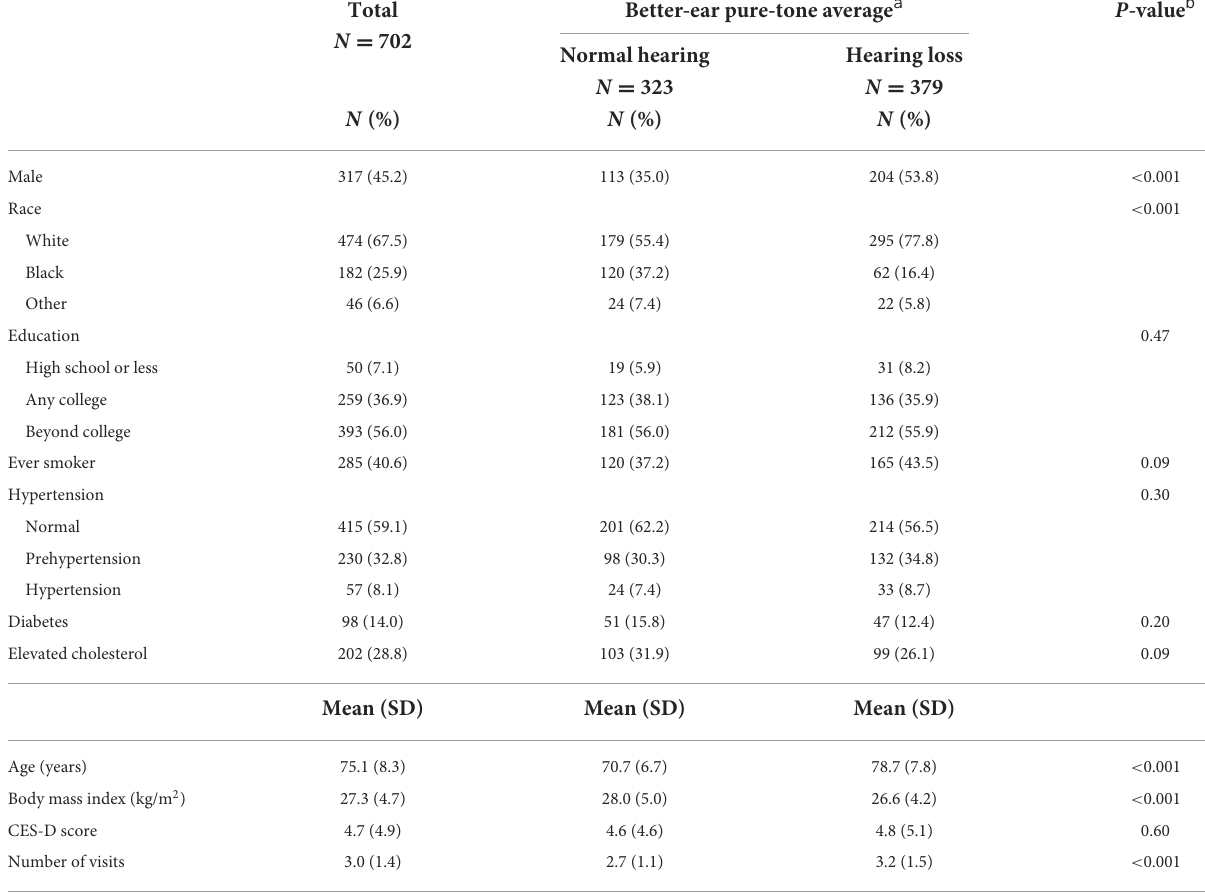
TABLE 2 Baseline characteristics of participants by audiometric hearing in the Baltimore Longitudinal Study of Aging